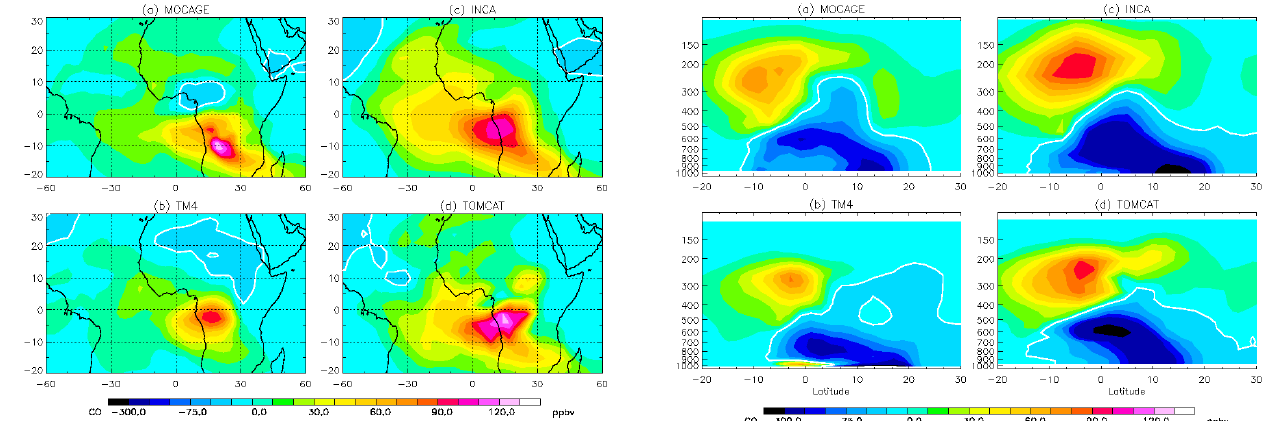
Fig. 7. August 2006 latitude-pressure cross-sections averaged over 0 ◦ –30 ◦ E of CO difference between LiNO x -off and Conv-off sim- ulations by (a) MOCAGE (b) TM4 (c) INCA and (d)